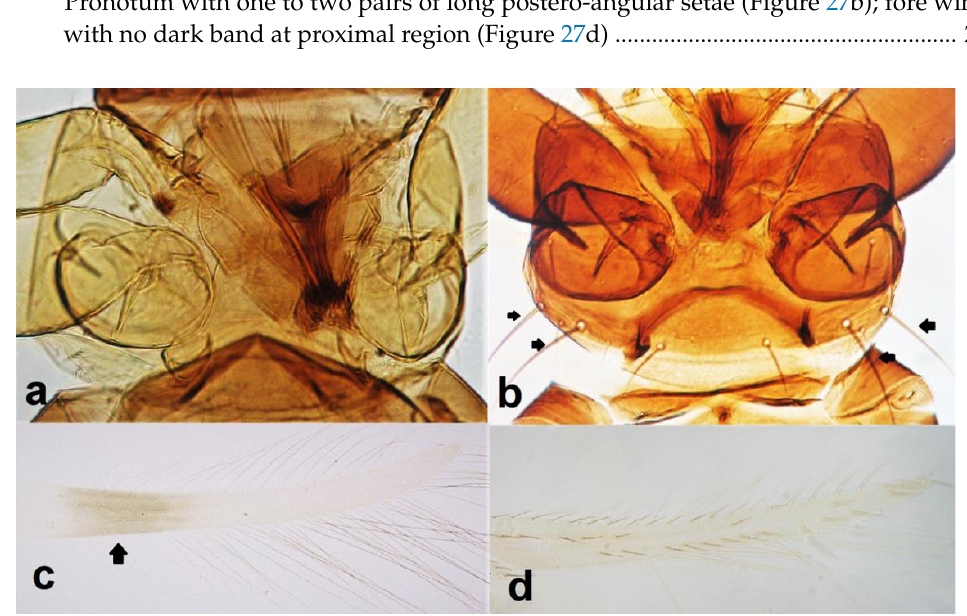
at proximal region (Figure 27c) ................................ Anaphothrips sudanensis Trybom